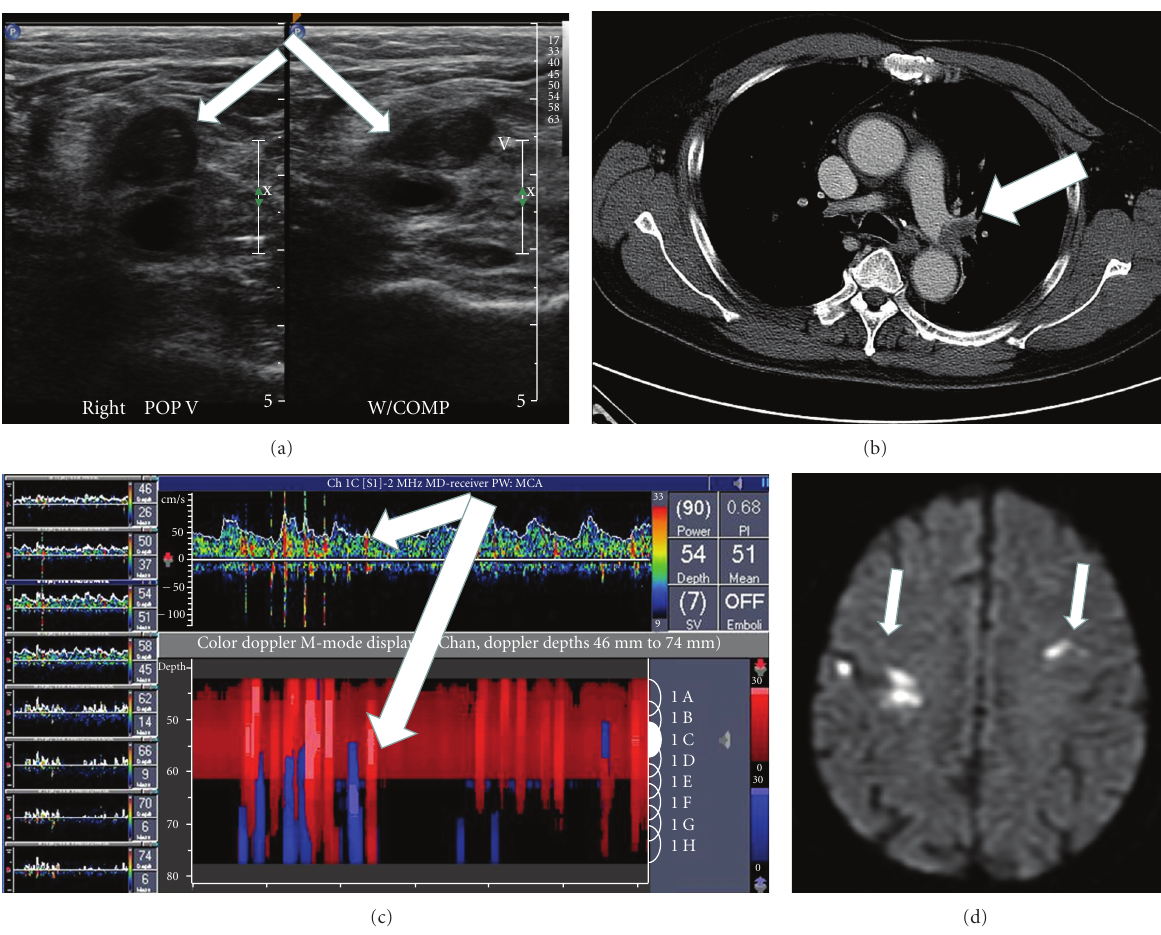
Figure 1: A 27-year-old woman, without any vascular risk factors, presented with mild right-sided weakness of suddenonset. She was noted to have swelling and pain in the right leg. Duplex sonography revealed extensive deep vein thrombosis involving the popliteal as well as superficial femoral vein, as characteristic noncompressibility and echogenic mass in the venous lumen. (a) Computerized tomographic angiography of thorax revealed filling defect in the left pulmonary artery. (b) Transcranial Doppler ultrasonographic monitoring of left middle cerebral artery during the “bubble test” (injection of agitated 9 mL normal saline and 1 mL air) revealed numerous microembolic signals, (c) suggestive of a right-to-left shunt (patent foramen ovale). Multiple acute ischemic infarcts involving many arterial territories were evident on the di ff usion-weighted magnetic resonance imaging of the brain. (d) Blood tests were positive for lupus anticoagulant and anticardiolipin